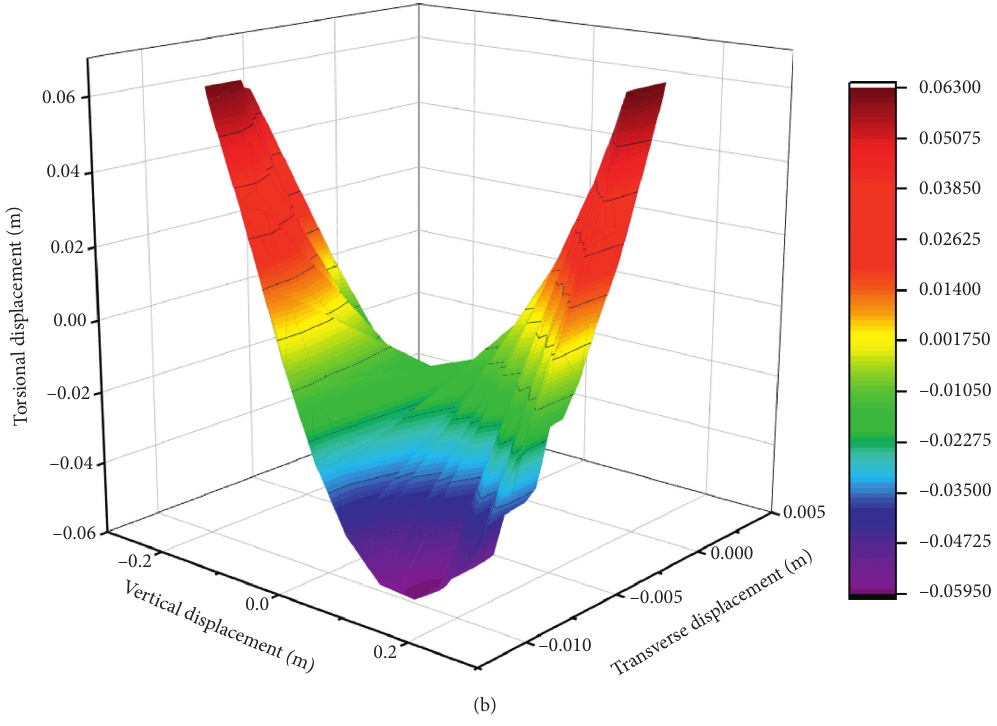
Figure 11: Amplitude diagrams. (a) Direct discrete method. (b) Indirect discrete